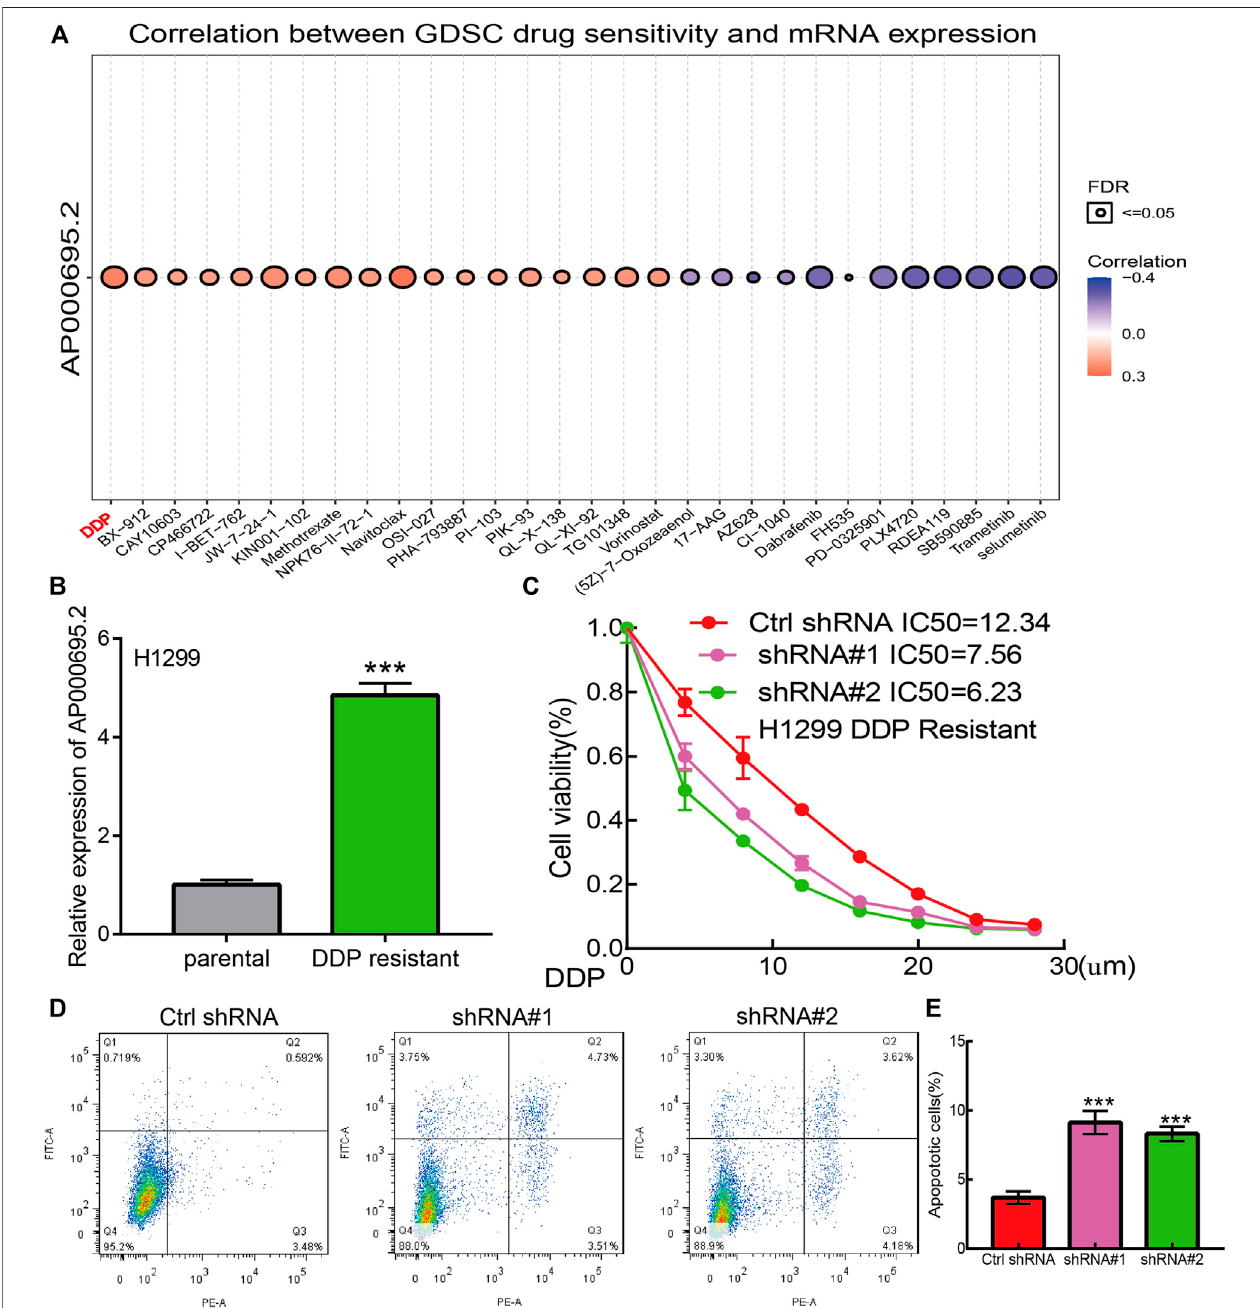
FIGURE 9 | lncRNA-AP000695.2 contributes to DDP resistance of LUAD. (A) Relationships between AP000695.2 expression and different drugs were examined by the GDSC database. (B) Expression of AP000695.2 in DDP-resistant and matched parental LUAD cells, normalized to 18sRNA expression. (C) AP000695.2 knockdown increases thesensitivity ofH1299/CDDP-resistant cells toCDDP, detected by CCK-8 assay. (D – E) AP000695.2 knockdown increases the CDDP-induced apoptosis rate in H1299/DDP-resistant cells detected by FCM.